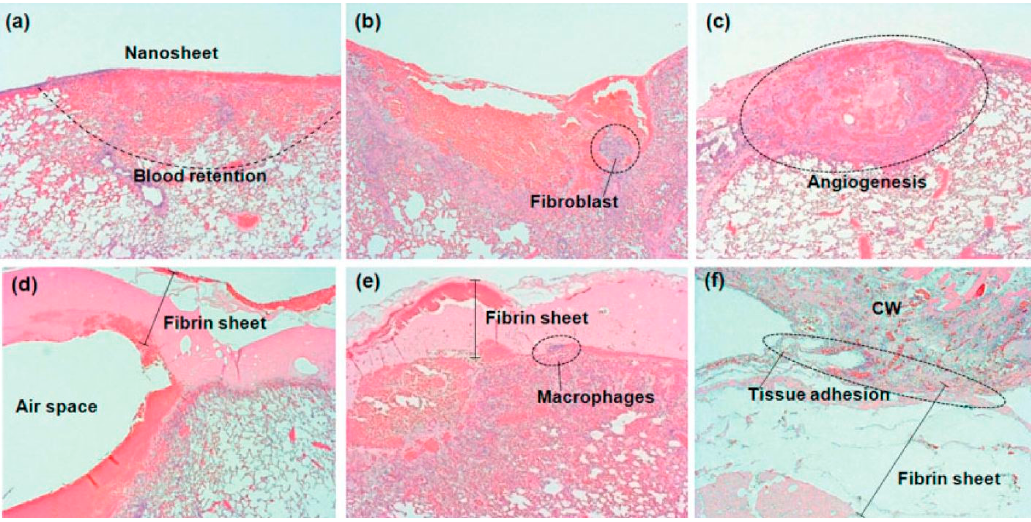
Figure 3. Upper panels correspond to the polysaccharide nanosheet, and lower panels correspond to the fibrin sheet, at 3 h ( a , d ), 3 days ( b , e ), and 7 days ( c , f ) after repair [19].